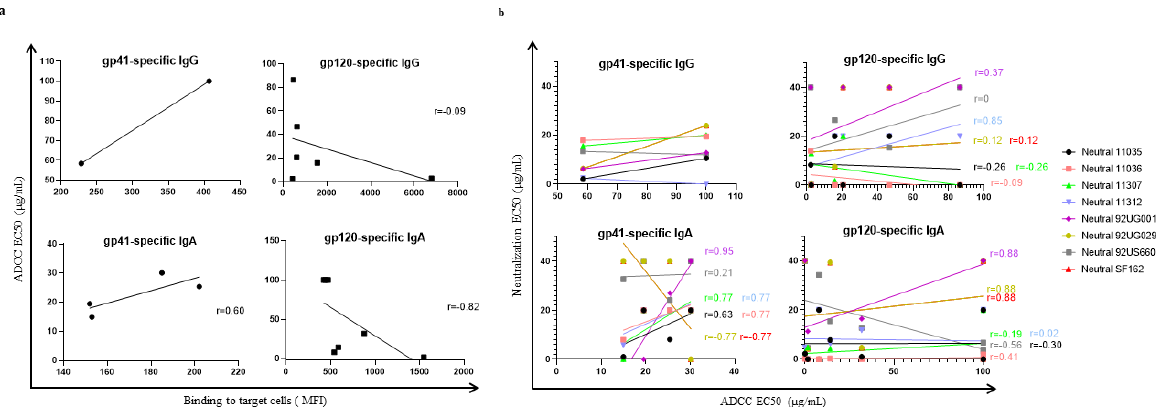
Figure 4. Correlation between: ( a ) MFI and ADCC-like EC50, ( b ) ADCC-like EC50 and Neutralization EC50. Each point represents the mean value of triplicates from two different experiments (n = 6). Non-parametric Spearman correlation was calculated for each case.